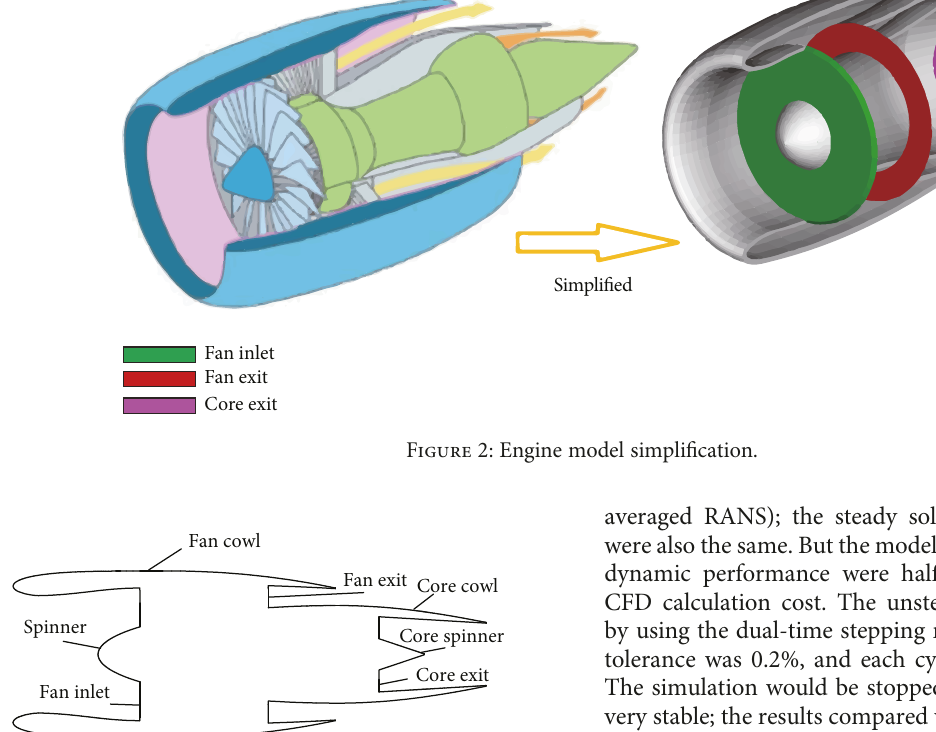
Figure 3: NAL-AERO-02-01 TPS test engine model.